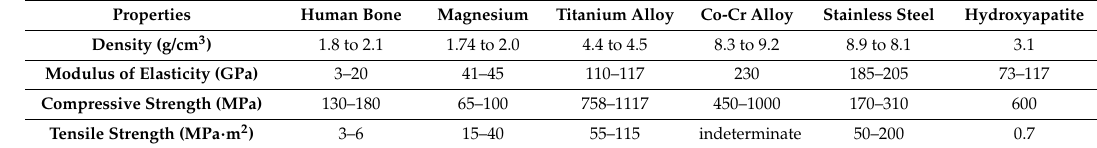
Table 1. Comparative physical property of various orthopedic